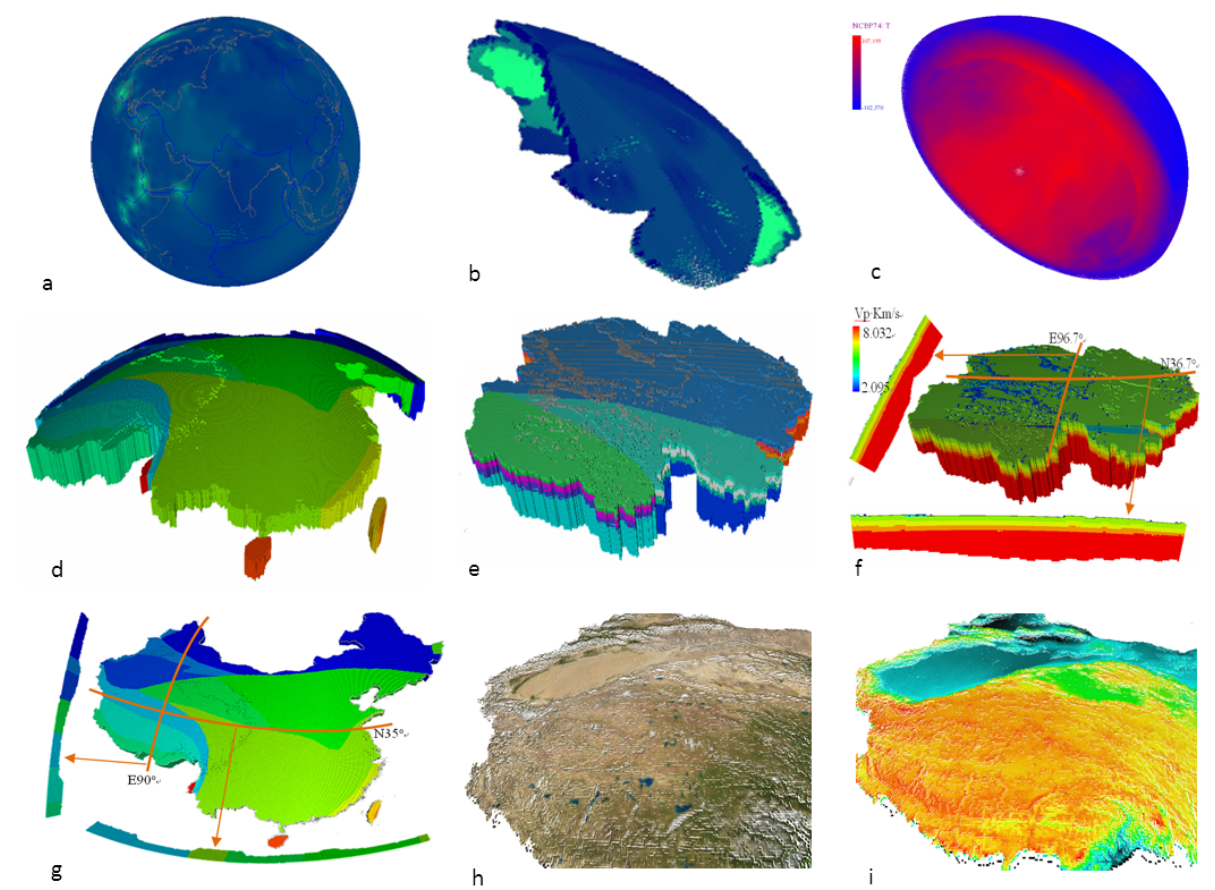
Figure 5.ESSG-based integral visualization of global big data on planet